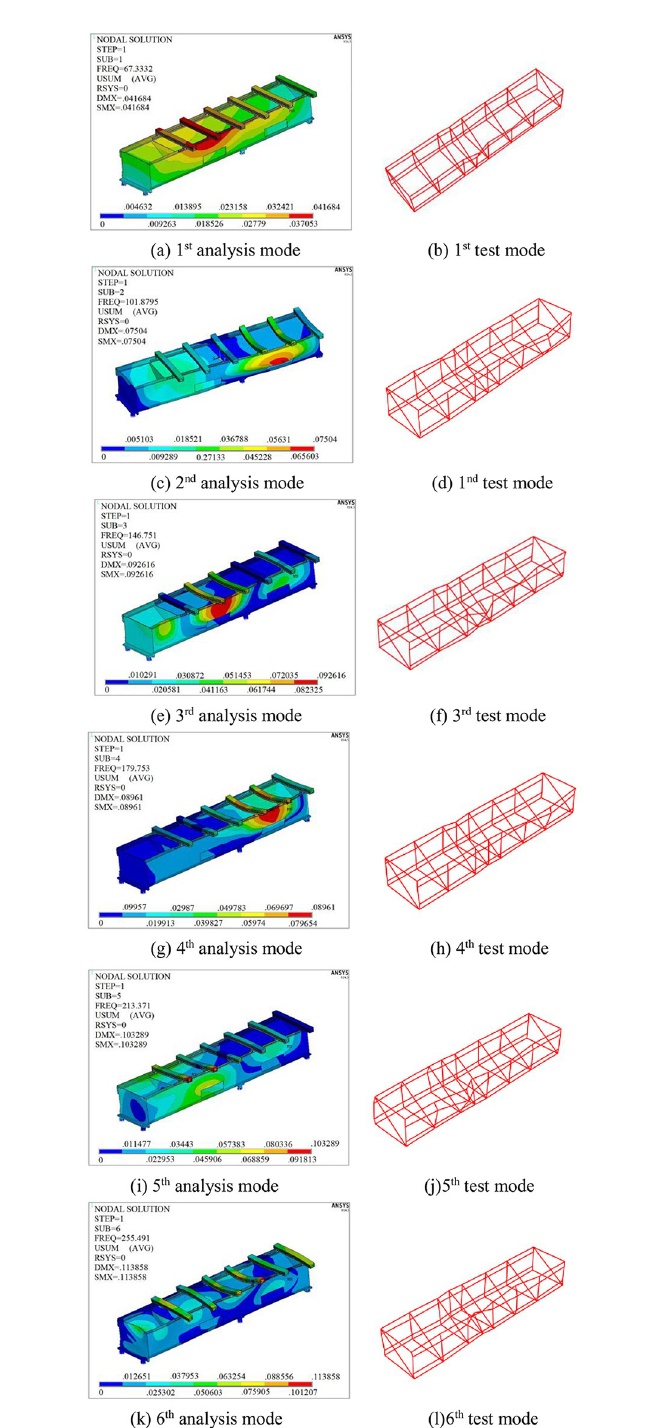
Fig 8. Comparison of modal modes between finite element modes and experimental modes. (a) 1 st analysis mode, (b) 1 st test mode, (c) 2 nd analysis mode, (d) 1 nd test mode, (e) 3 rd analysis mode, (f) 3 rd test mode, (g) 4 th analysis mode, (h) 4 th test mode, (i) 5 th analysis mode, (j)5 th test mode, (k) 6 th analysis mode, (l)6 th test mode.